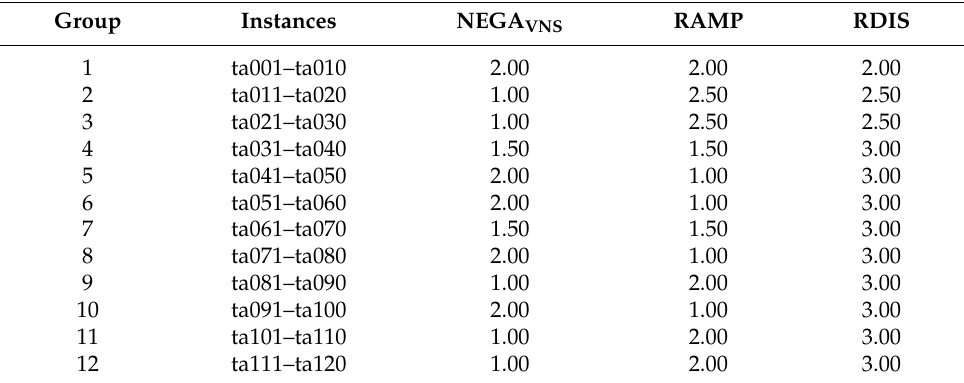
Table 5. NEGA VNS , RAMP, and RDIS ranked based on %DEV avg for each problem group. Group